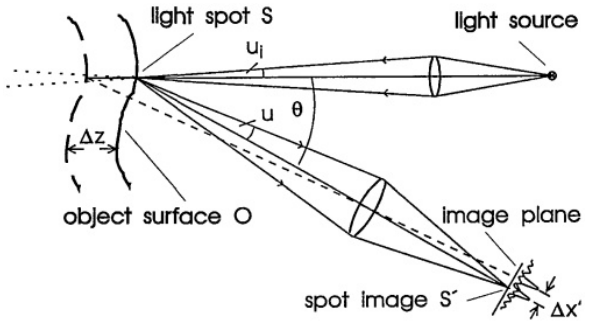
Figure 9. Laser line triangulation (Dorsch et al., 1994)